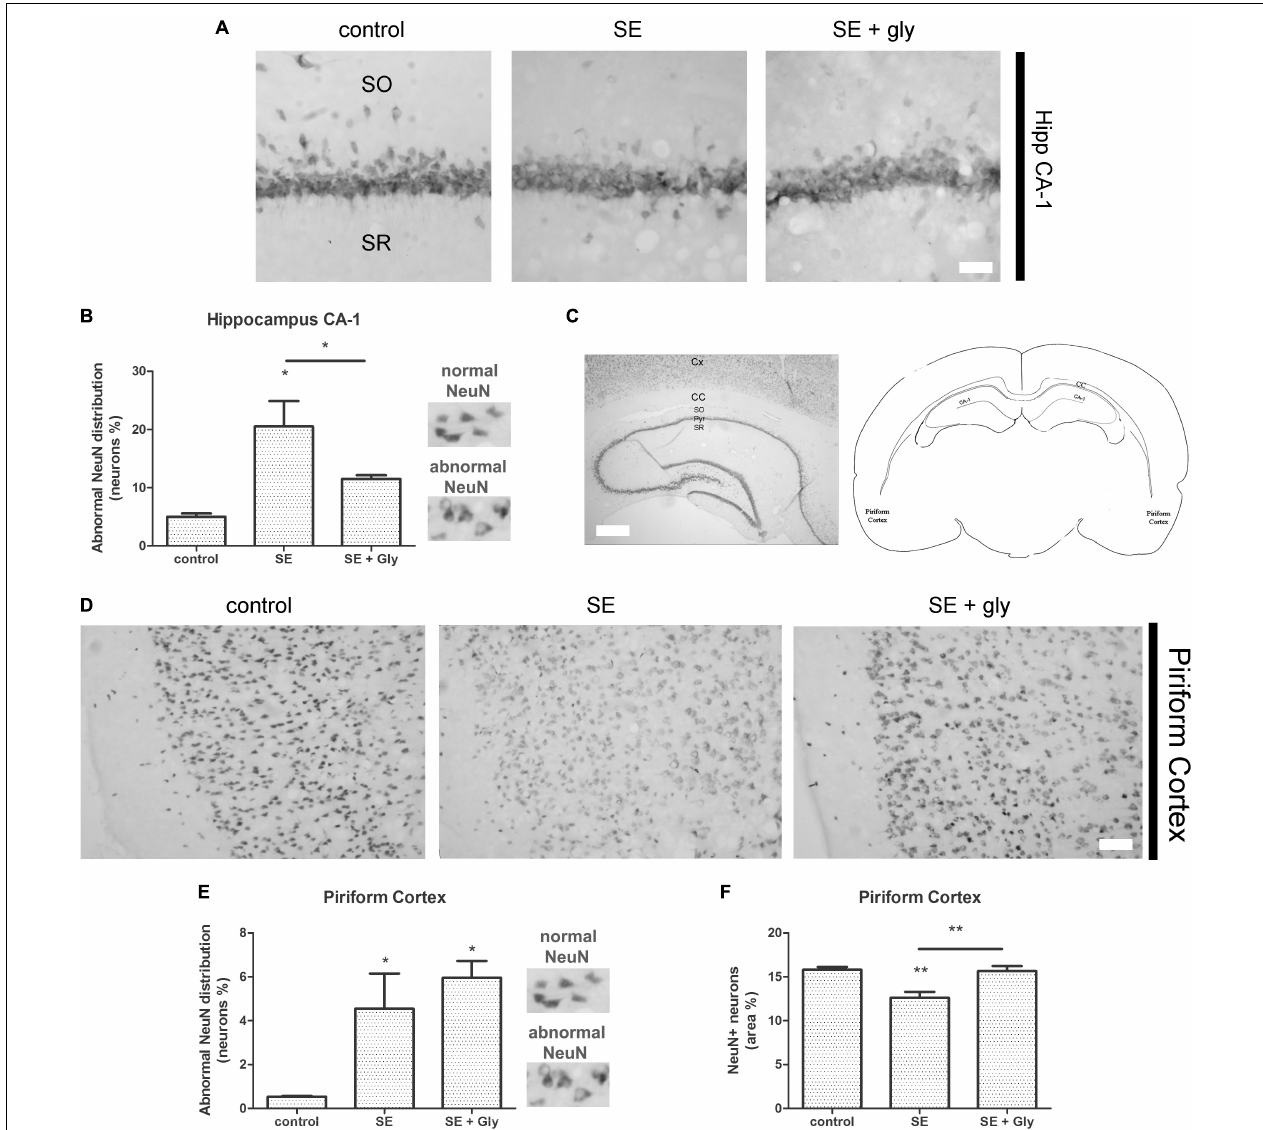
FIGURE 9 | HMGB-1 antagonist glycyrrhizin improves neuronal survival after pilocarpine-induced SE. Rats were exposed to pilocarpine-induced SE, treated with glycyrrhizin or vehicle for 4 days and analyzed after 15 days. (A) Representative images of NeuN immunostaining that labels the CA-1 hippocampal pyramidal neurons. Stratum Oriens (SO) and Stratum Radiatum (SR) are also shown. Note the decreased NeuN immunostaining and NeuN relocalization to the cytoplasm, both features of neurodegeneration, in SE-exposed animals and the partial recovery induced by glycyrrhizin treatment. Scale bar: 28 µ m. (B) Quantitative analysis of NeuN-immunostained neurons showing atypical NeuN localization in the cytoplasm in the CA-1 pyramidal cell layer of control, SE and SE animals treated with glycyrrhizin. (C) Low magnification of the NeuN-immunostained hippocampus to visualize the different regions and the typical NeuN labeling of hippocampal neurons. Scale bar: 350 µ m. Cx, Brain cortex; CC, Corpus Callosum; SO, Stratum Oriens; Pyr, Pyramidal cell layer; SR, Stratum Radiatum; CA-1, Hippocampal CA-1 area. The scheme shows the localization of the analyzed areas in a coronal rat brain section (D) Representative images of NeuN-immunostained neurons in the piriform cortex, images were taken in caudal position to the necrotic core. The absence of NeuN immunostaining in the brain cortical layer I ( moleculare ), scale bar: 40 µ m. (E) Quantitative analysis of the atypical NeuN-immunostained neurons showing the NeuN redistribution to the cytoplasm in the piriform cortex of control, SE and SE animals treated with glycyrrhizin. (F) Quantitative analysis of the total area of NeuN-immunostained neurons in the piriform cortex of control, SE and SE animals treated with glycyrrhizin. Note that glycyrrhizin treatment did not prevent the atypical NeuN localization but significantly reduced neuronal loss induced by SE. Statistical analyses were performed by one way ANOVA and Student Newman–Keuls post-test, with statistical significance represented as ∗ p < 0.05, ∗∗ p < 0.01, and ∗∗∗ p < 0.001. The number of animals were n = 6 per experimental group.